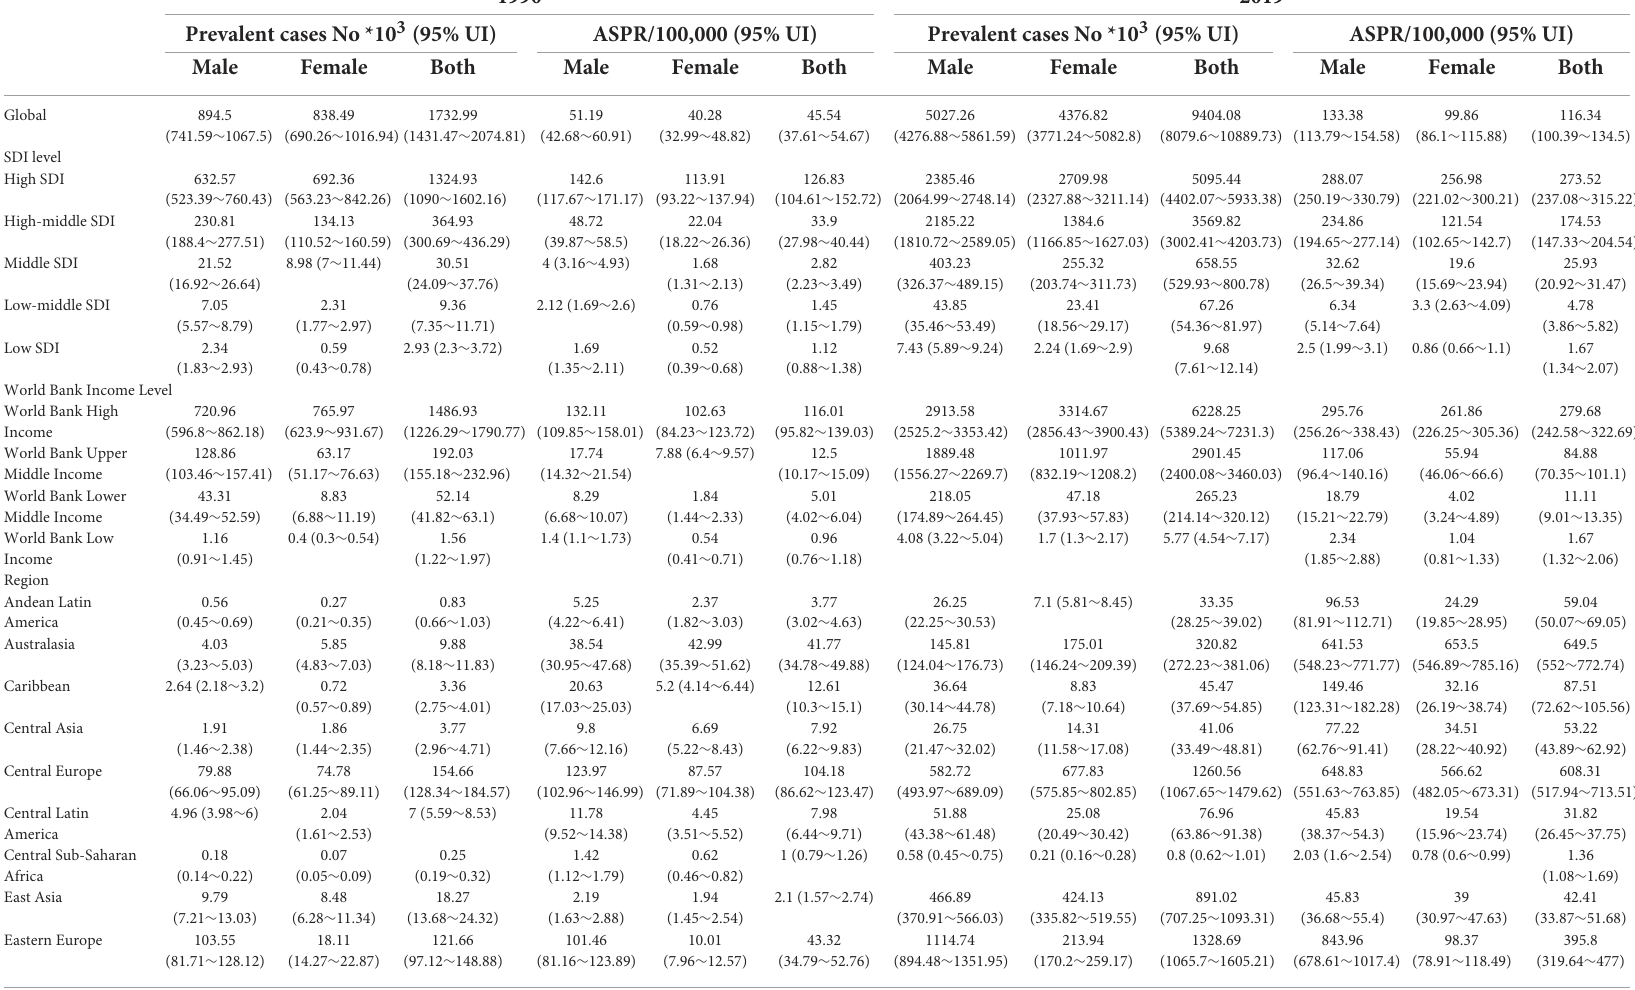
TABLE 2 The prevalence of CAVD in